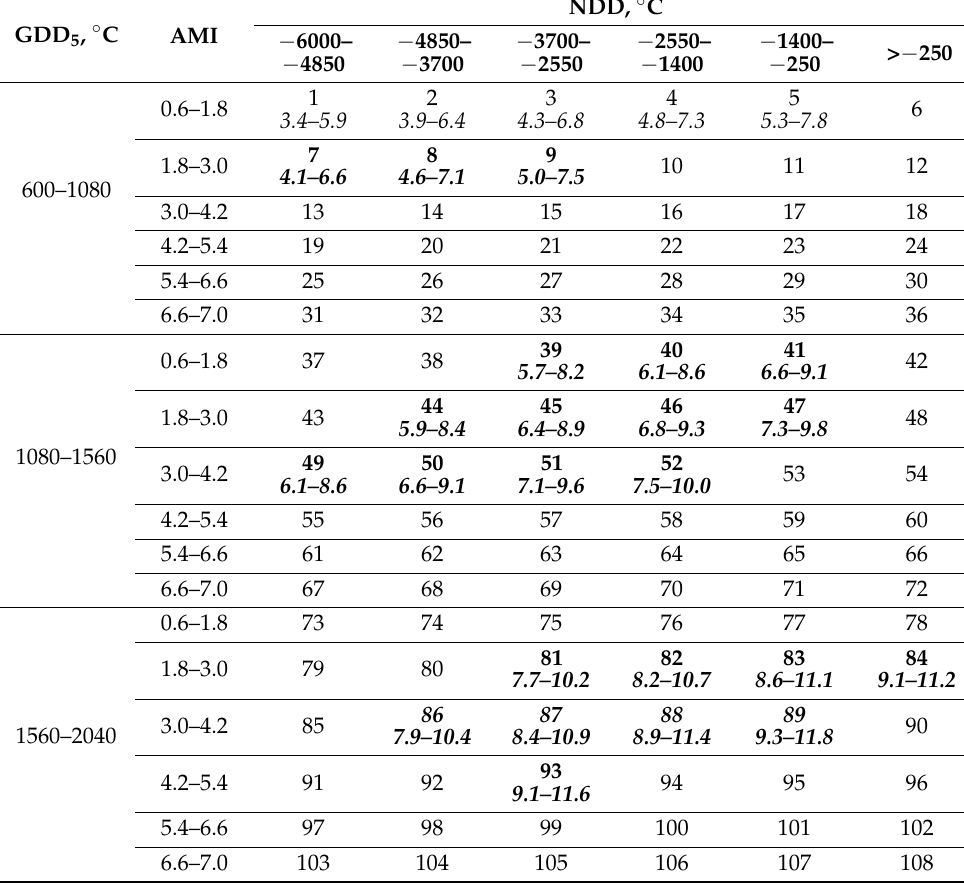
Table 1. Climatic limits (GDD5, NDD, and AMI) of 180 potential seed zones (#), 39 realized seed zones (>1% of the total range, bold), and their modeled seed mass (g/1000 seed, italic) in current and CMIP5 RCP2.6 and RCP 8.5 climates in